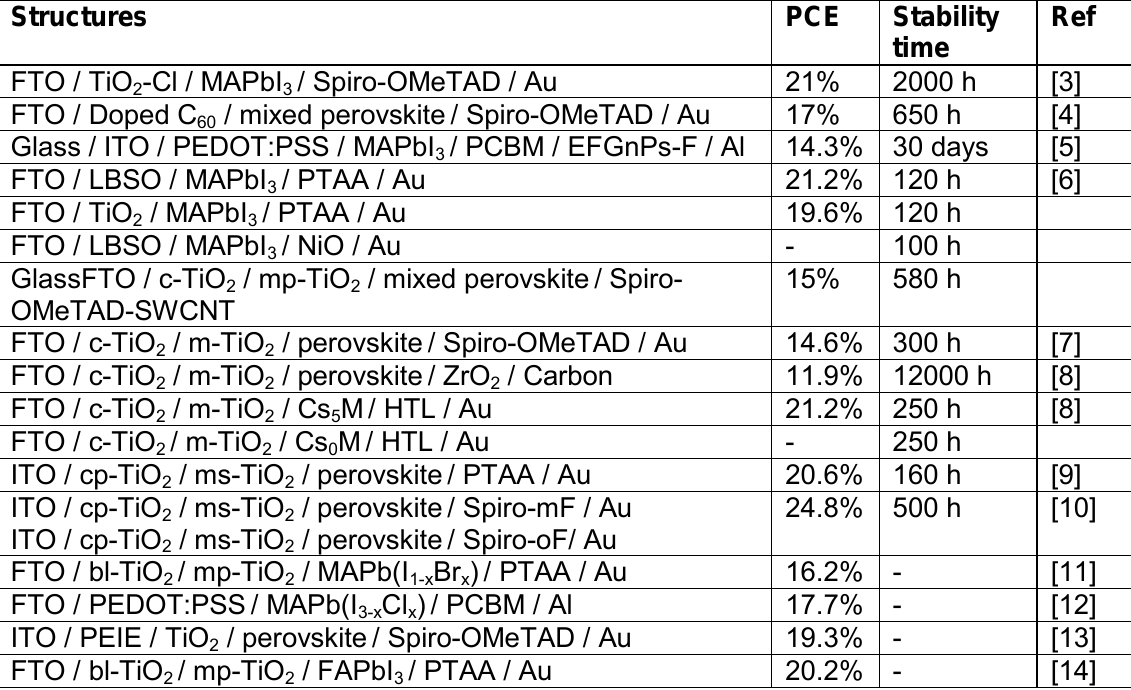
Table 1. The different structures of the perovskite-based cell studied in the literature.